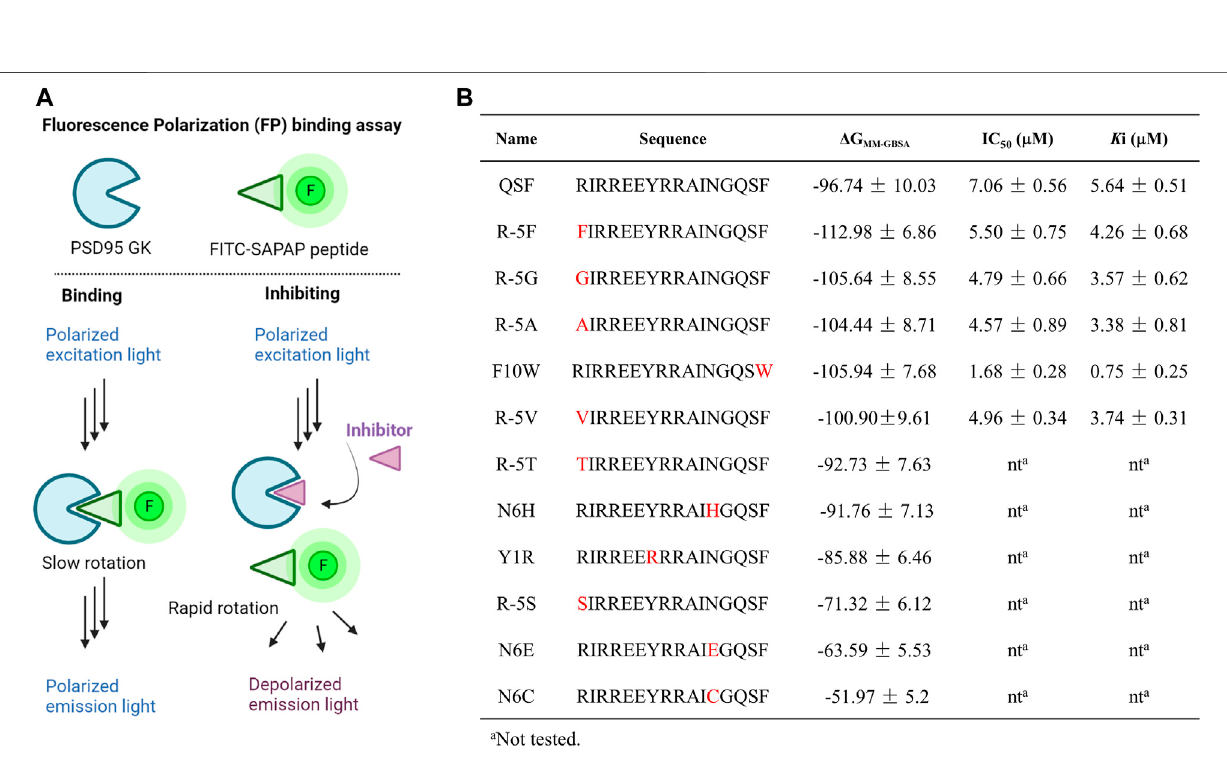
Frontiers in Molecular Biosciences |